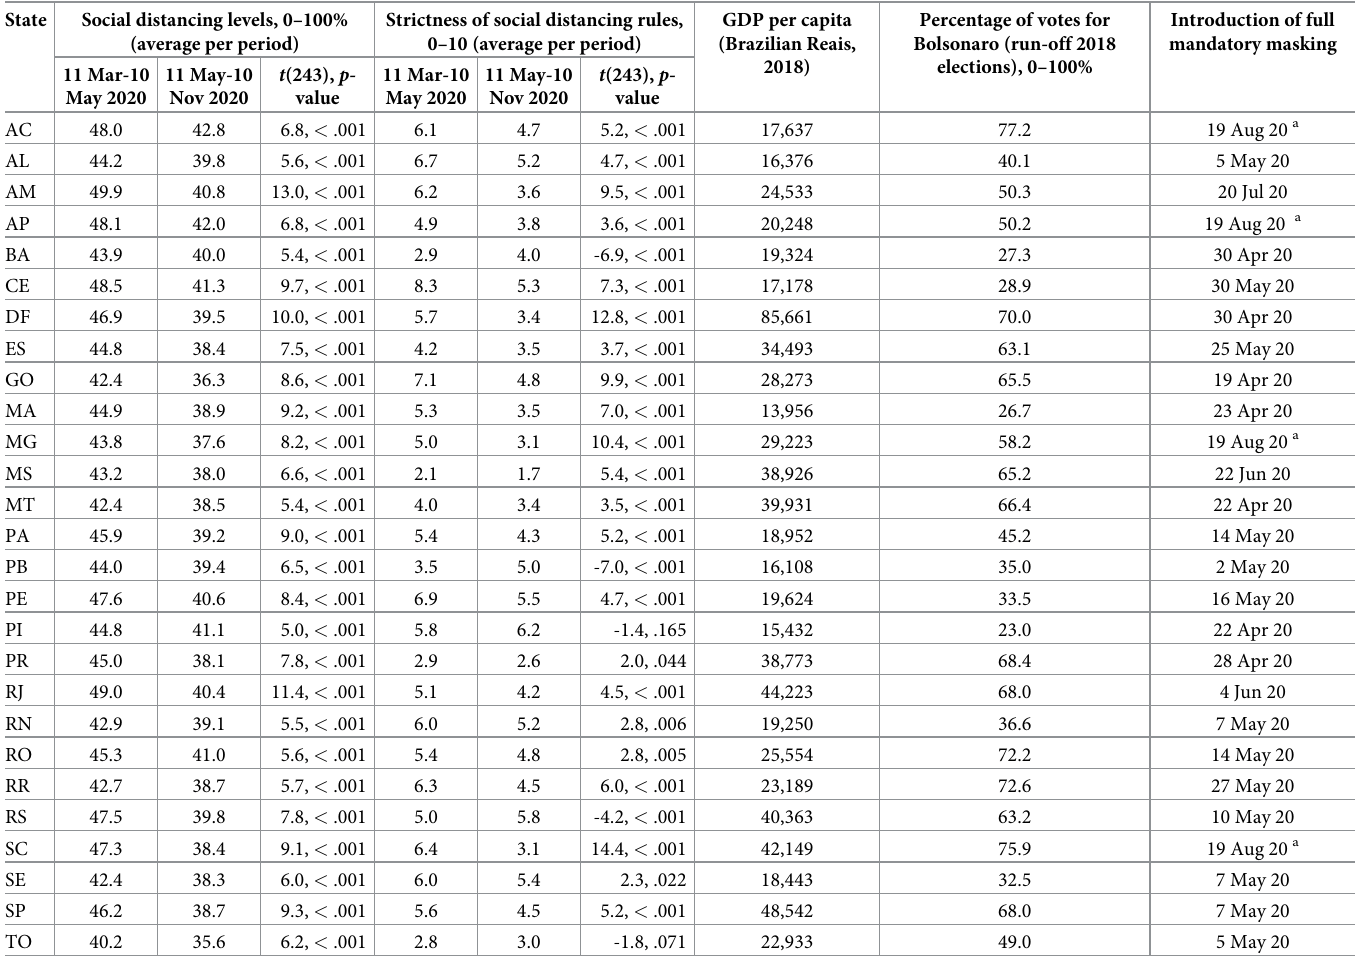
Table 1. Measures of social distancing, strictness of social distancing rules and other variables, by state,